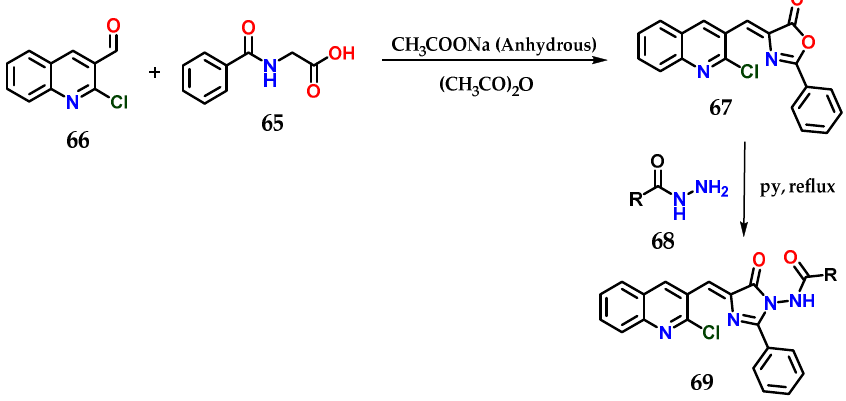
Figure 26. Synthesis of N -(4-((2-chloroquinolin-3-yl)methylene)-5-oxo-2-phenyl-4,5-dihydro-1 H - imidazol-1-yl)(aryl)amides 69 .